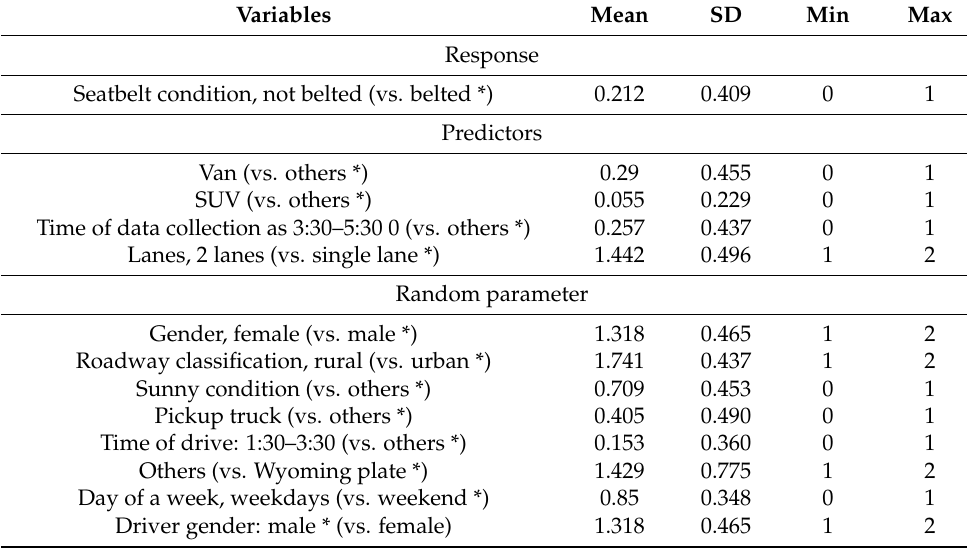
Table 1. Descriptive summary of important variables and